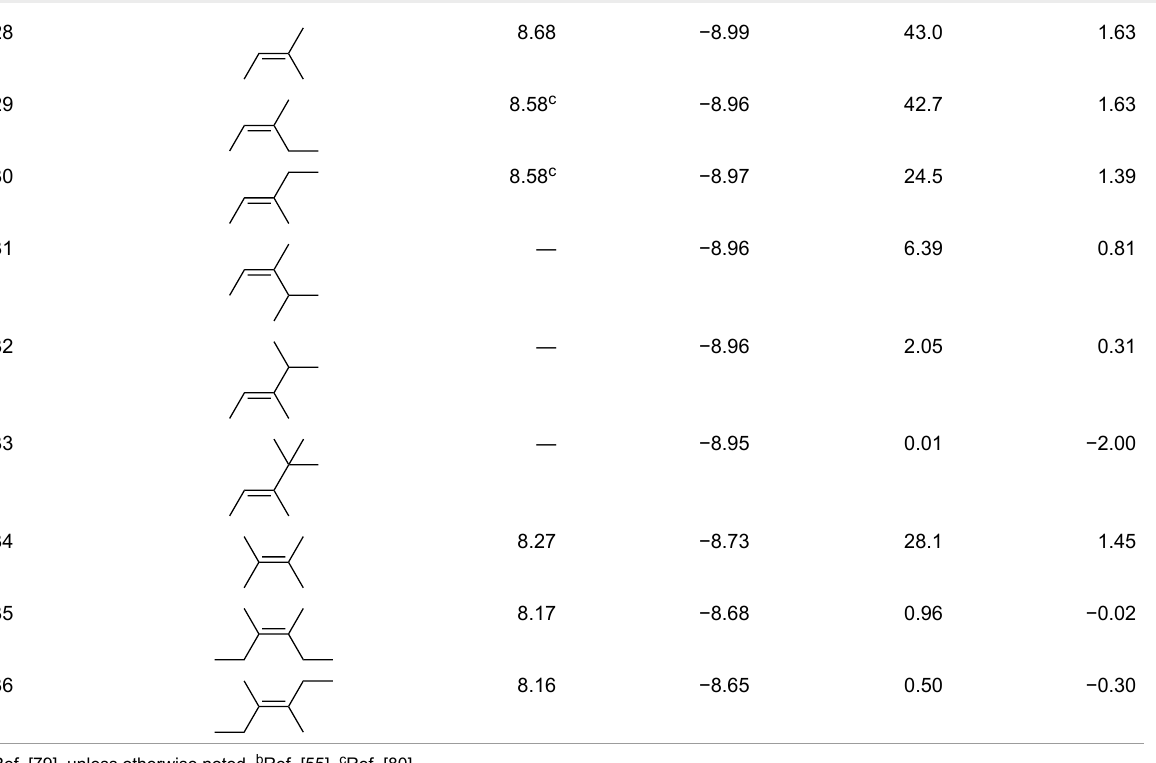
Table 1: Representative alkene IEs (eV), HOMO energies (eV), relative rates ( k rel ), and log k rel values of PhSeCl additions at 25 °C. (continued)